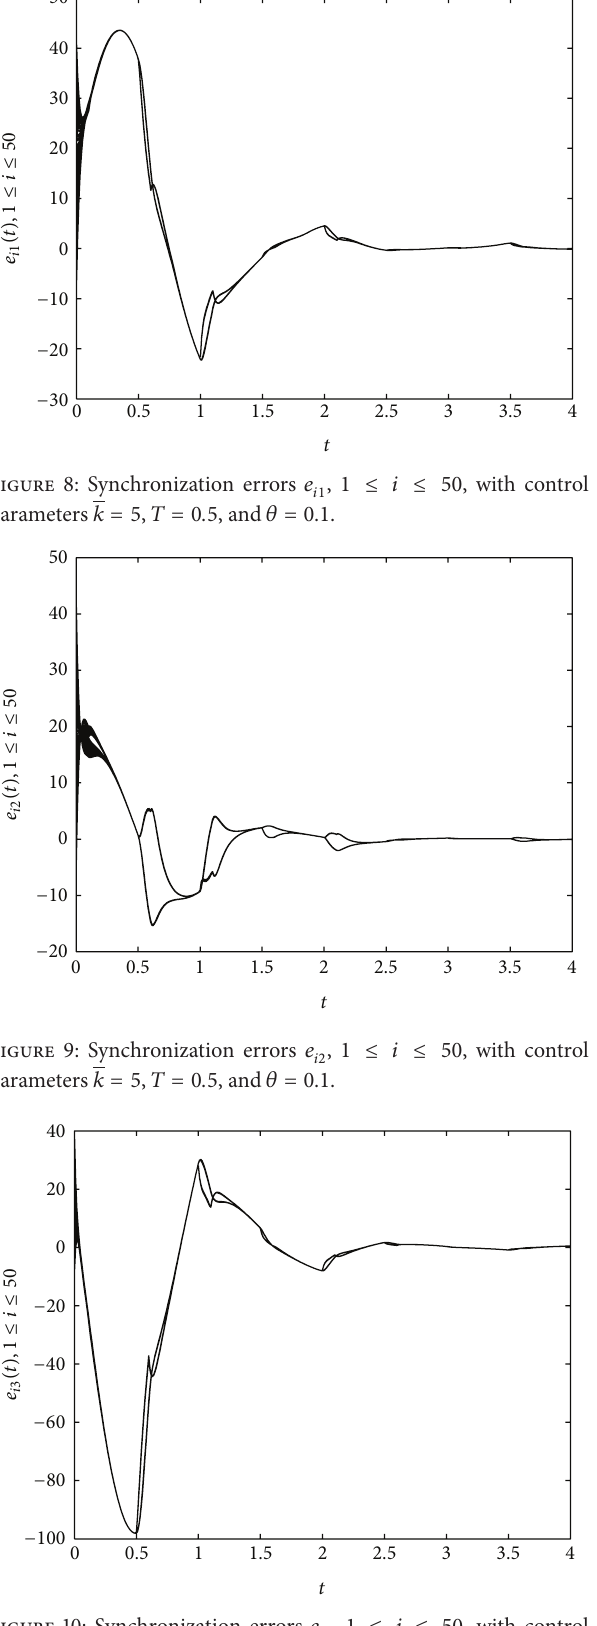
Figure 10: Synchronization errors 𝑒 𝑖 3 , 1 ≤ 𝑖 ≤ 50, with control parameters 𝑘 = 5, 𝑇 = 0 . 5, and 𝜃 = 0 . 1.